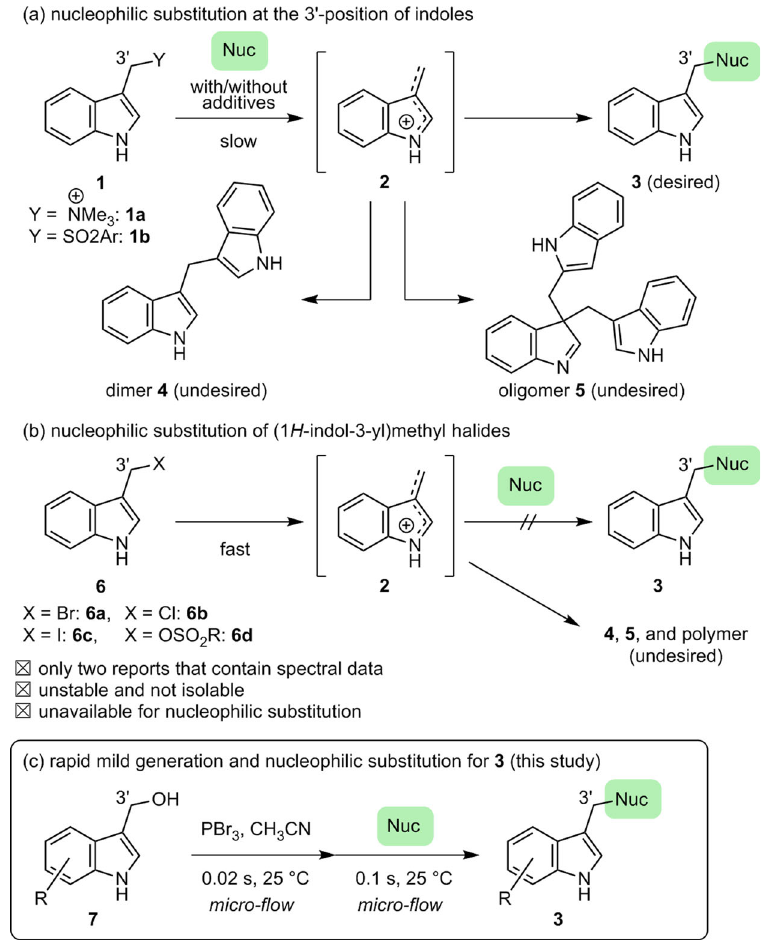
Fig. 1 Nucleophilic substitutions at the 3 ’ -position of substituted indoles. a Nucleophilic substitution using methylated gramine 1a and aryl sulfone 1b . b Nucleophilic substitution using (1 H -indol-3-yl)methyl halide 6 . c This study: rapid mild generation and nucleophilic substitution in a micro fl ow